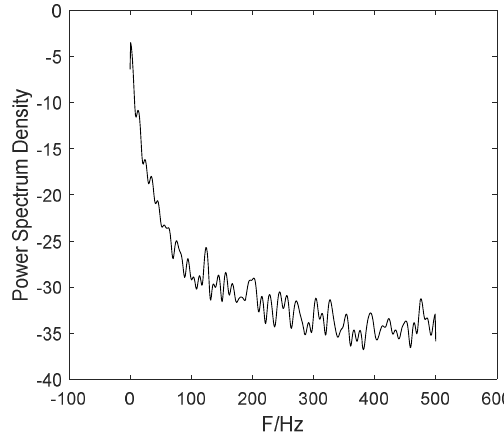
Figure 6. 1/f Noise power spectral density.